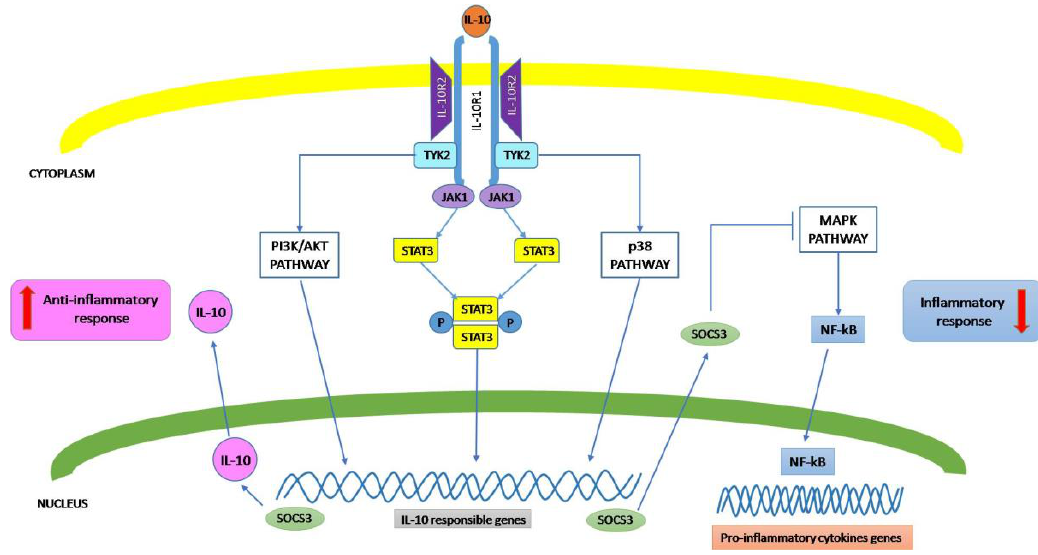
Figure 1. Scheme illustrating the IL-10 signaling pathway.